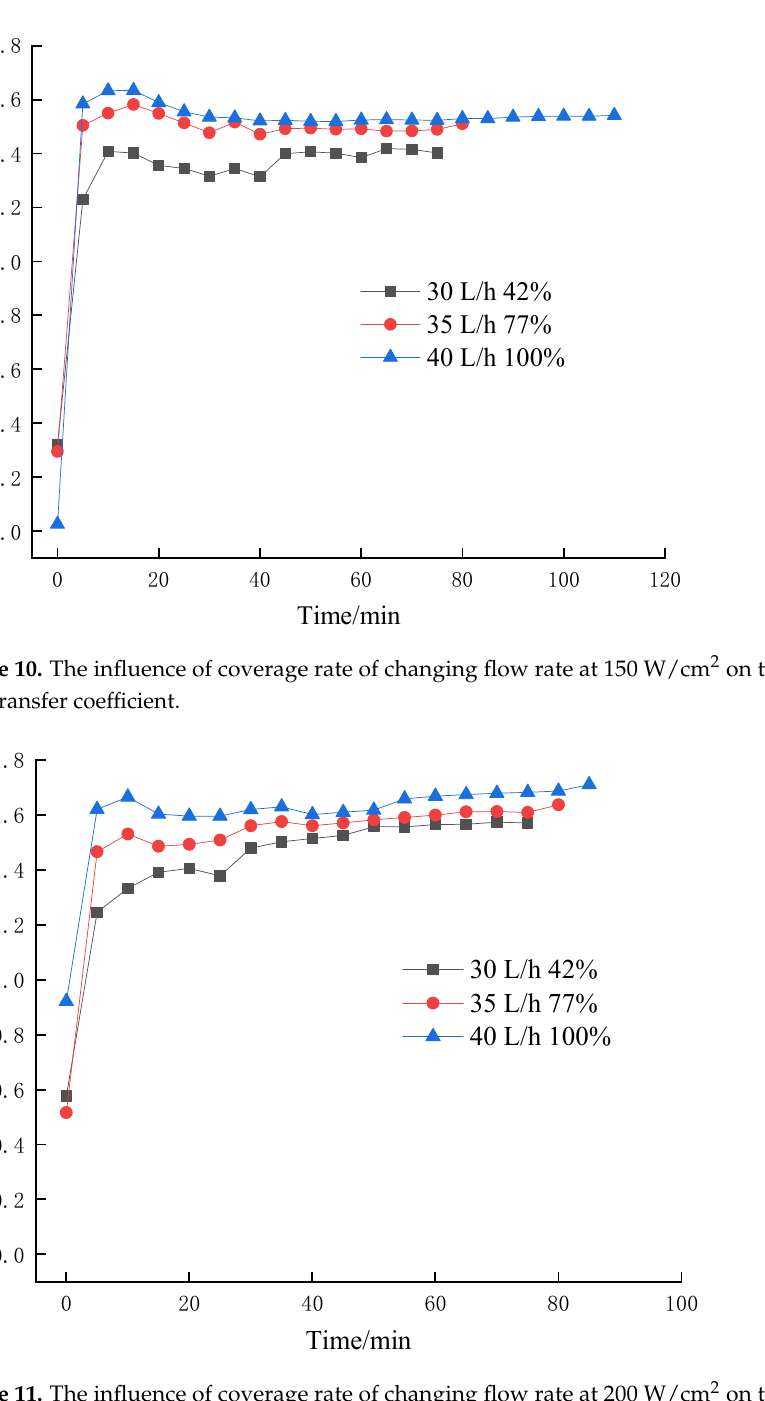
Figure 9. The influence of coverage rate of changing flow rate at 100 W/cm 2 on transient surface heat transfer coefficient.